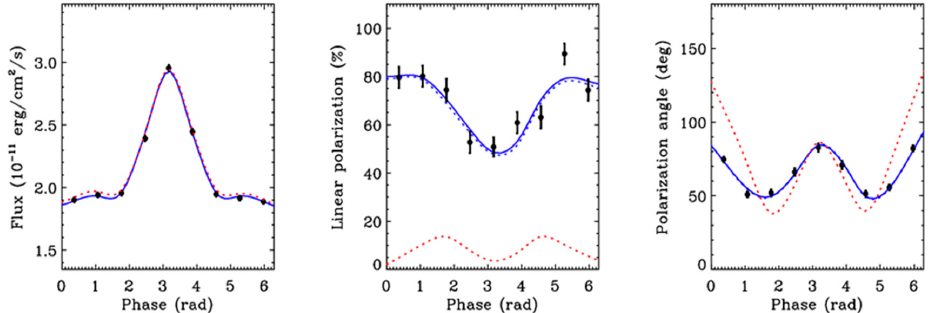
Figure 15. ( Left ) Linear polarization versus energy for various black hole spin parameters; ( right ) Position angle with respect to an arbitrary reference. Dotted lines are based on model calculations. Solid lines are fits to the data based on a 200 ksec IXPE observation.